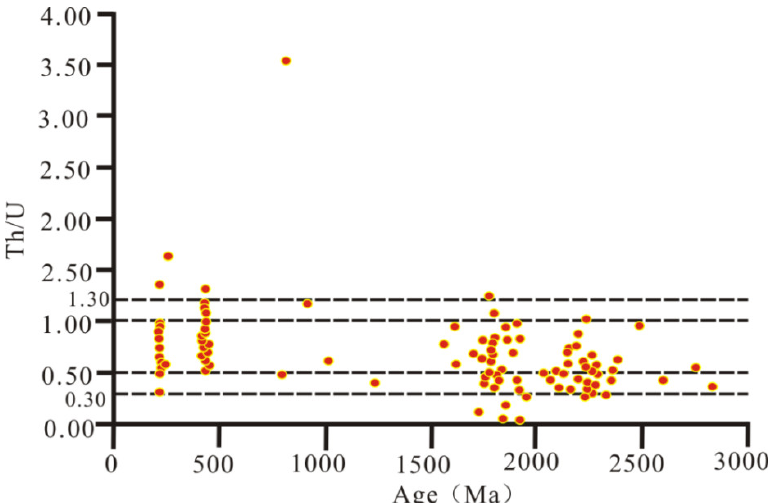
Figure 6. Th/U ratio vs. Zircon ages diagram of detrital zircons from sandstone samples of the Zhi- luo Formation in the Yongshou area.